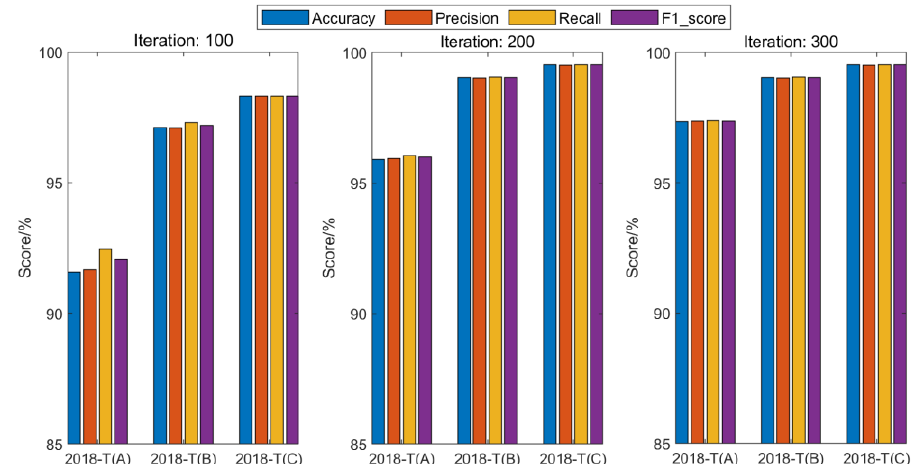
Figure 14. XGBoost performance using raw sample sets with different iteration numbers.